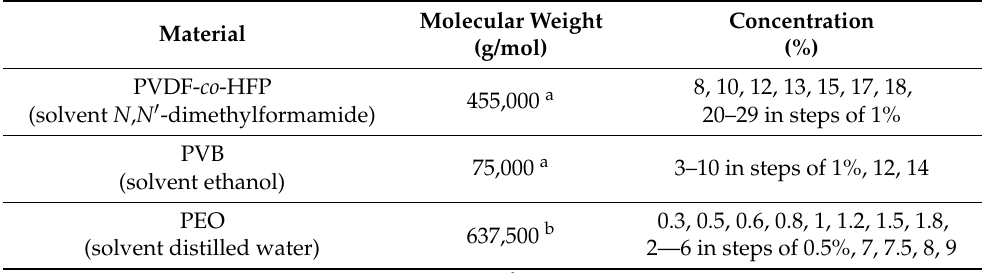
Molecular Weight (g/mol)